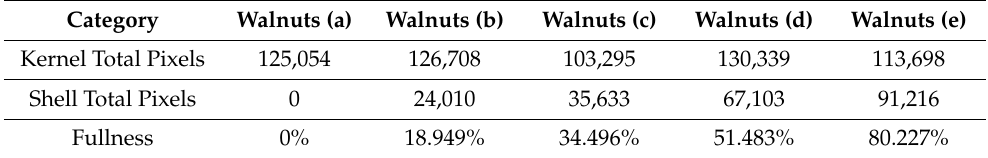
Table 5. Fullness of walnut kernel in physical image.